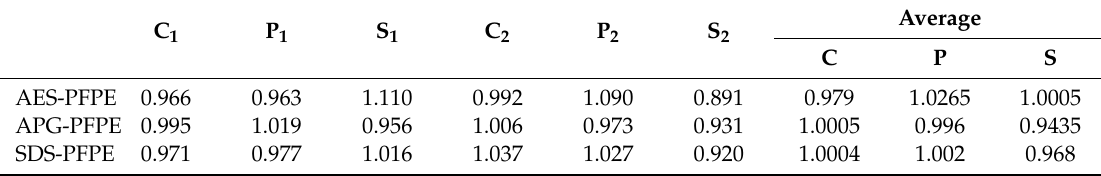
Table 5. Decontamination index of various